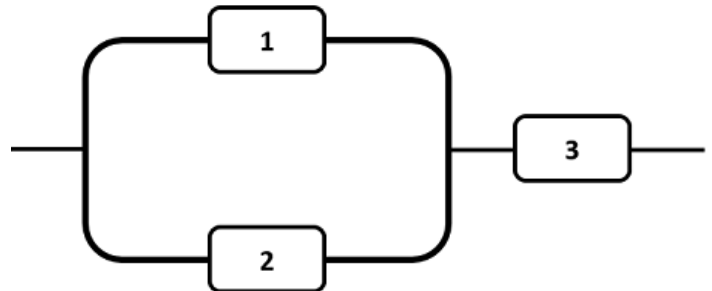
Figure 5. Case study 1: Flow transmission system (flow direction is left to right).